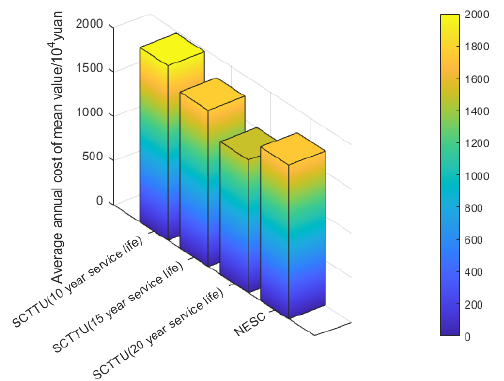
Figure 5. Blind number mean value of annual average cost of NESC and SCTTU.